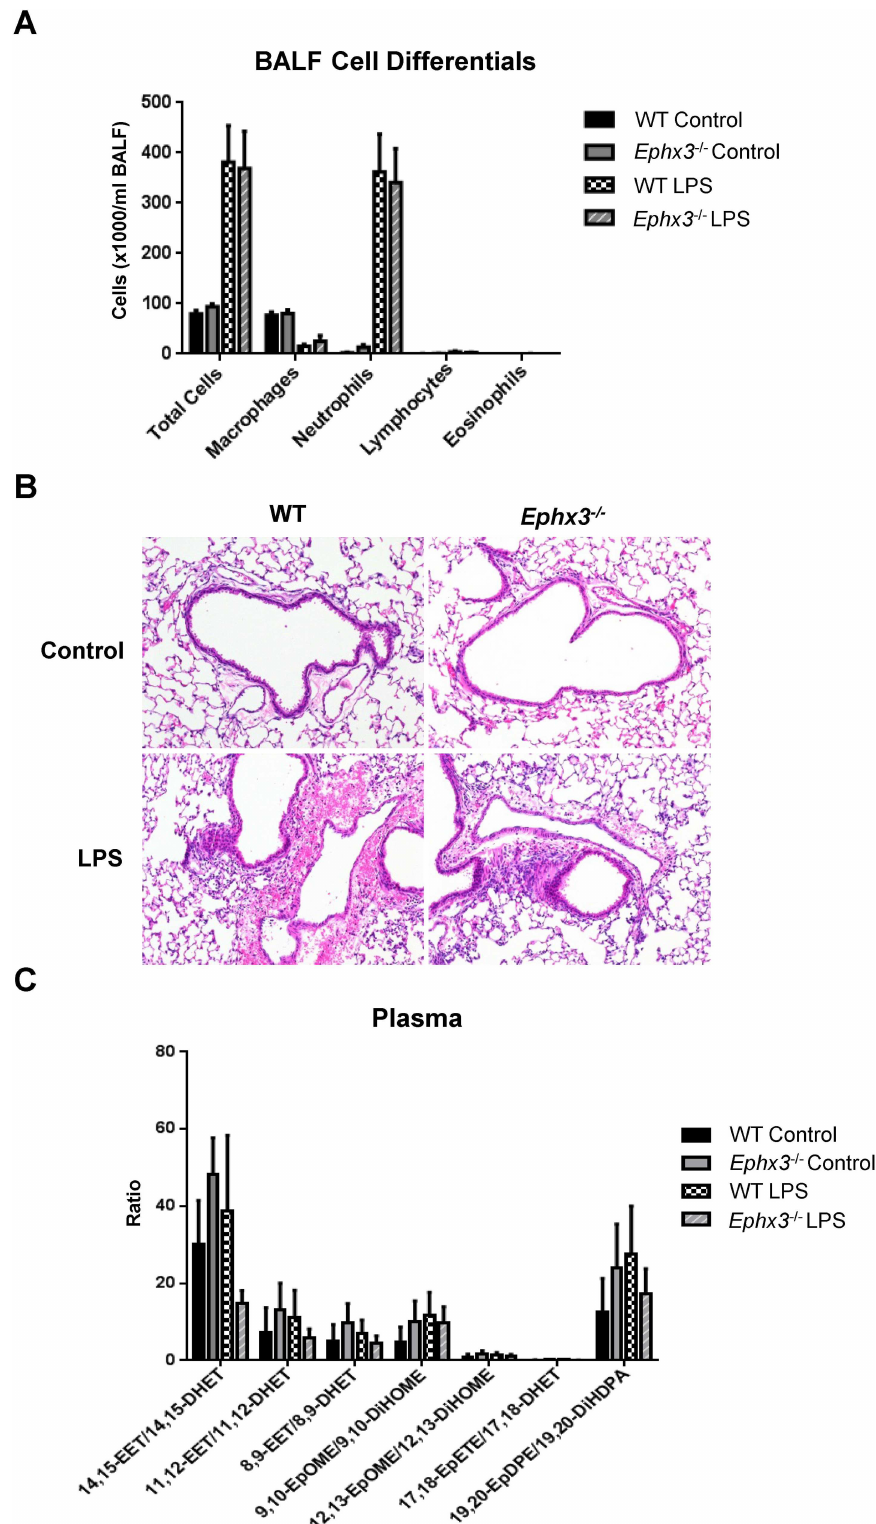
Fig 8. Bronchoalveolar lavage fluid cells, lung histology, and plasma epoxide:diol ratios are unchanged in Ephx3 -/- mice after LPS treatment. (A) Bronchoalveolarlavage fluid cell counts